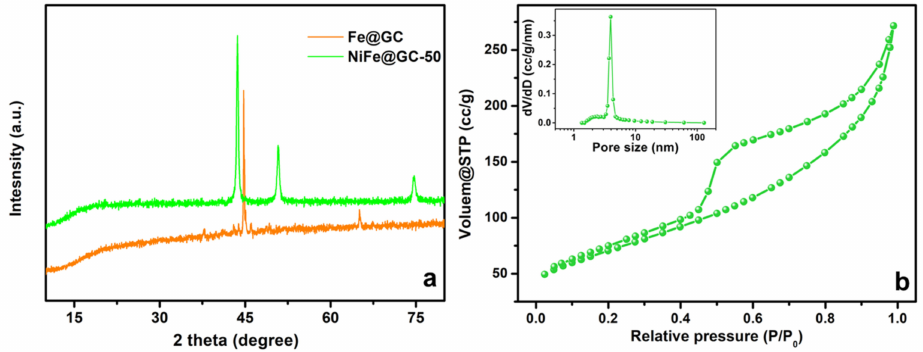
Figure 2. ( a ) XRD patterns of NiFe@GC-50 and Fe@GC, ( b ) N 2 adsorption–desorption isothermal of